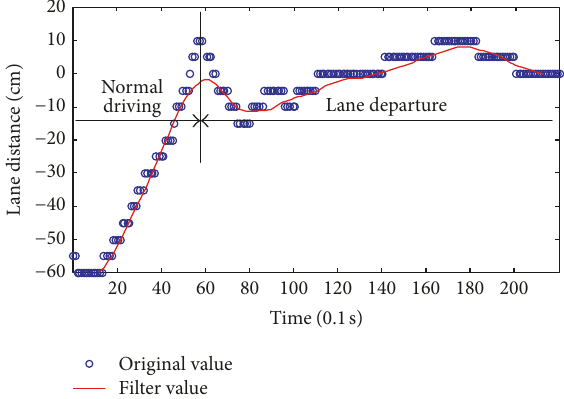
Figure 4: Lane line distance changes during lane departure behav-